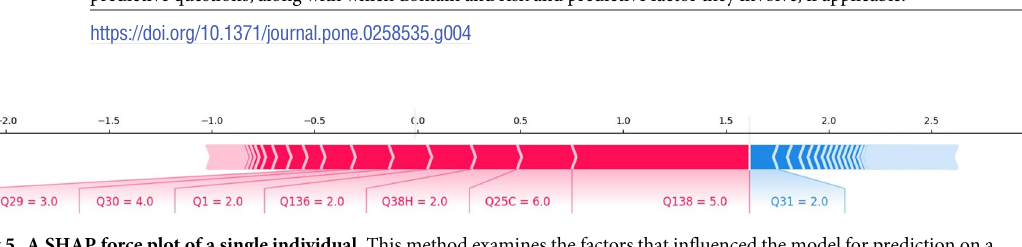
PLOS ONE | https://doi.org/10.1371/journal.pone.0258535 November3,